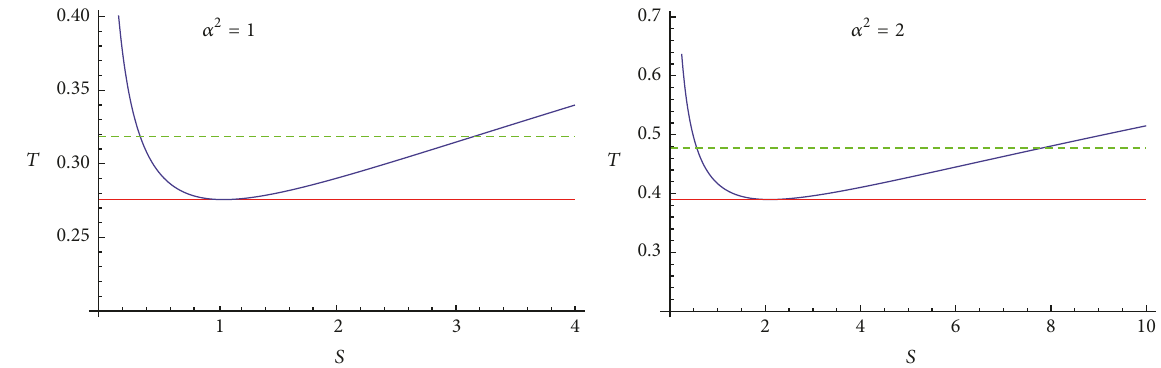
Figure 1: The black hole temperature in terms of entropy. The dashed green line represents the Hawking-Page transition temperature, while thesolid red line standsfor 𝑇 min . When 𝑇 < 𝑇 min , there isonly a thermal gas solution in theAdS space. When 𝑇 > 𝑇 min , for a given temperature 𝑇 , there exist two black hole solutionsgiven by (23). The one with large horizon is stable, while it is thermodynamically unstablefor the smaller one.